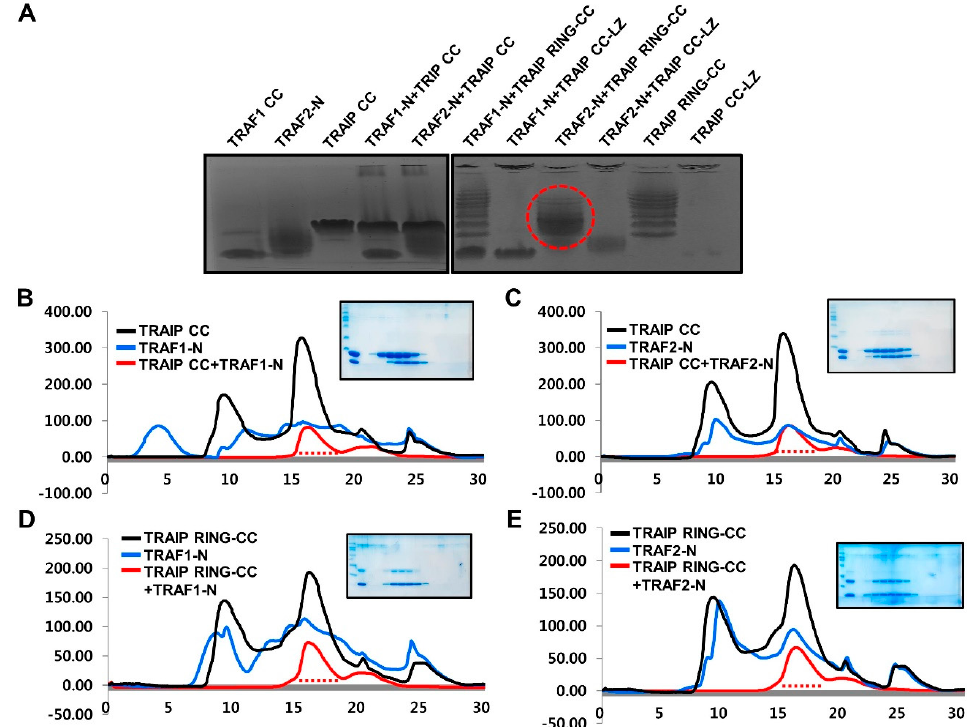
Figure 5. Only TRAIP RING-CC interacts with TRAF2 TRAF-N specifically in vitro. ( A ) Native PAGE shift assay with various constructs of TRAIP and TRAF-N domains of TRAF1 and TRAF2. TRAIP CC-LZ indicates TRAIP containing coiled-coil and leucine zipper domains. The red-dotted circle indicates only the shifted band that formed by formation of the complex; ( B – E ) Size-exclusion chromatography profiles of mixture of TRAIP CC and TRAF1 TRAF-N ( B ), TRAIP CC and TRAF2 TRAF-N ( C ), TRAIP RING-CC and TRAF1 TRAF-N ( D ), and TRAIP RING-CC and TRAF2 TRAF-N ( E ).